Question: Condense the content of this figure into a single sentence.
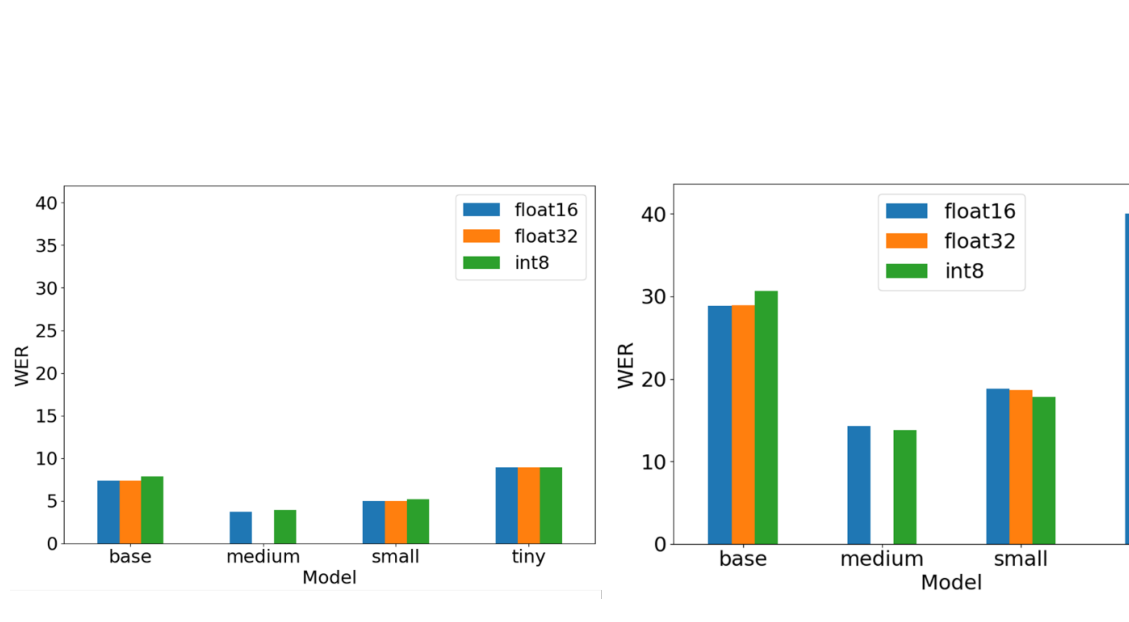
Answer: Impact of model quantization on word error rate (WER) for clean (left) and noisy  audio (right) in whisperx models.